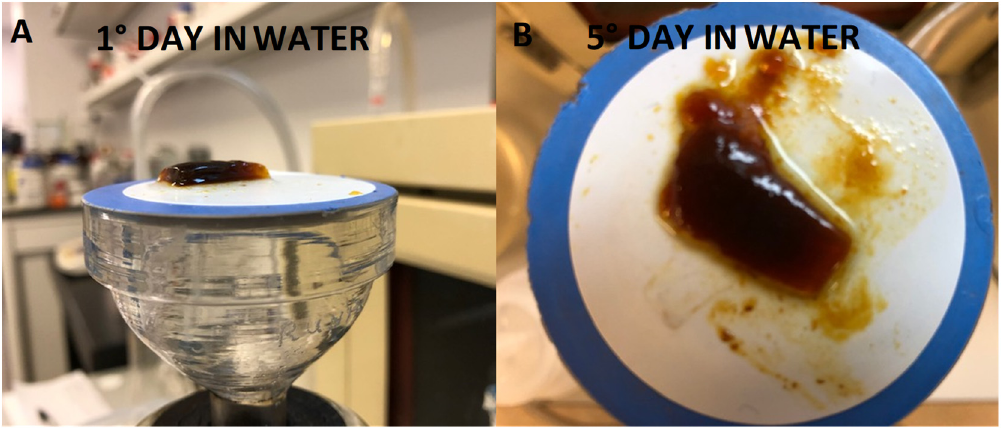
Figure 5. Swollen appearance of SDF loaded CNC film. ( A ) day 1; ( B ) day 5.